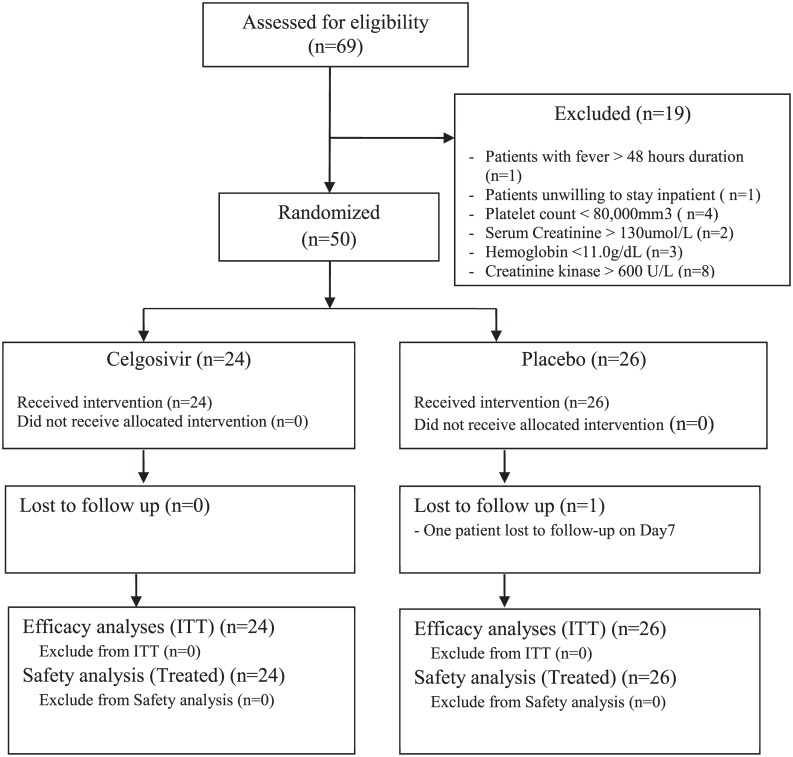
Subject disposition for CELADEN study [17].